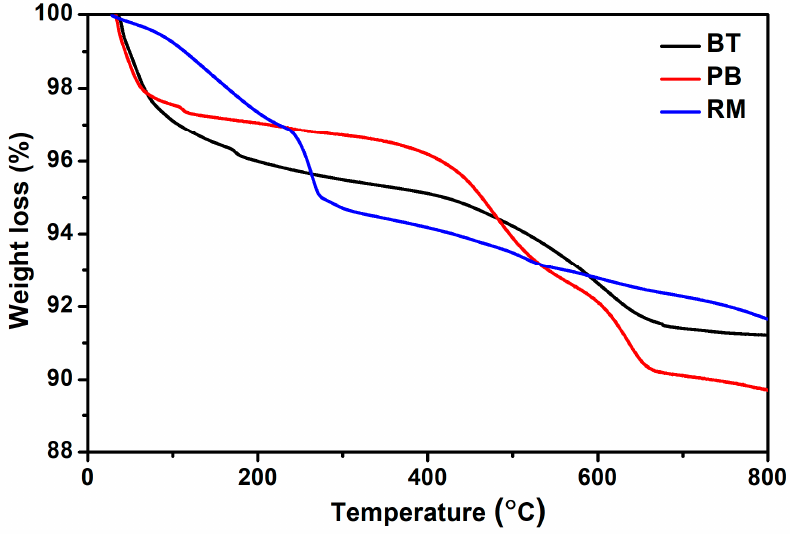
Figure 7. Thermogravimetric analysis (TGA) of BT, PB, and RM adsorbent.